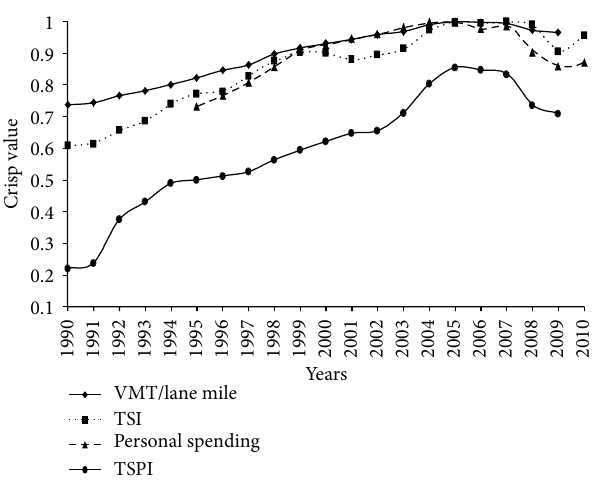
Figure 4: Historical Trend of Environmental System Performance Index and its Performance Measures.